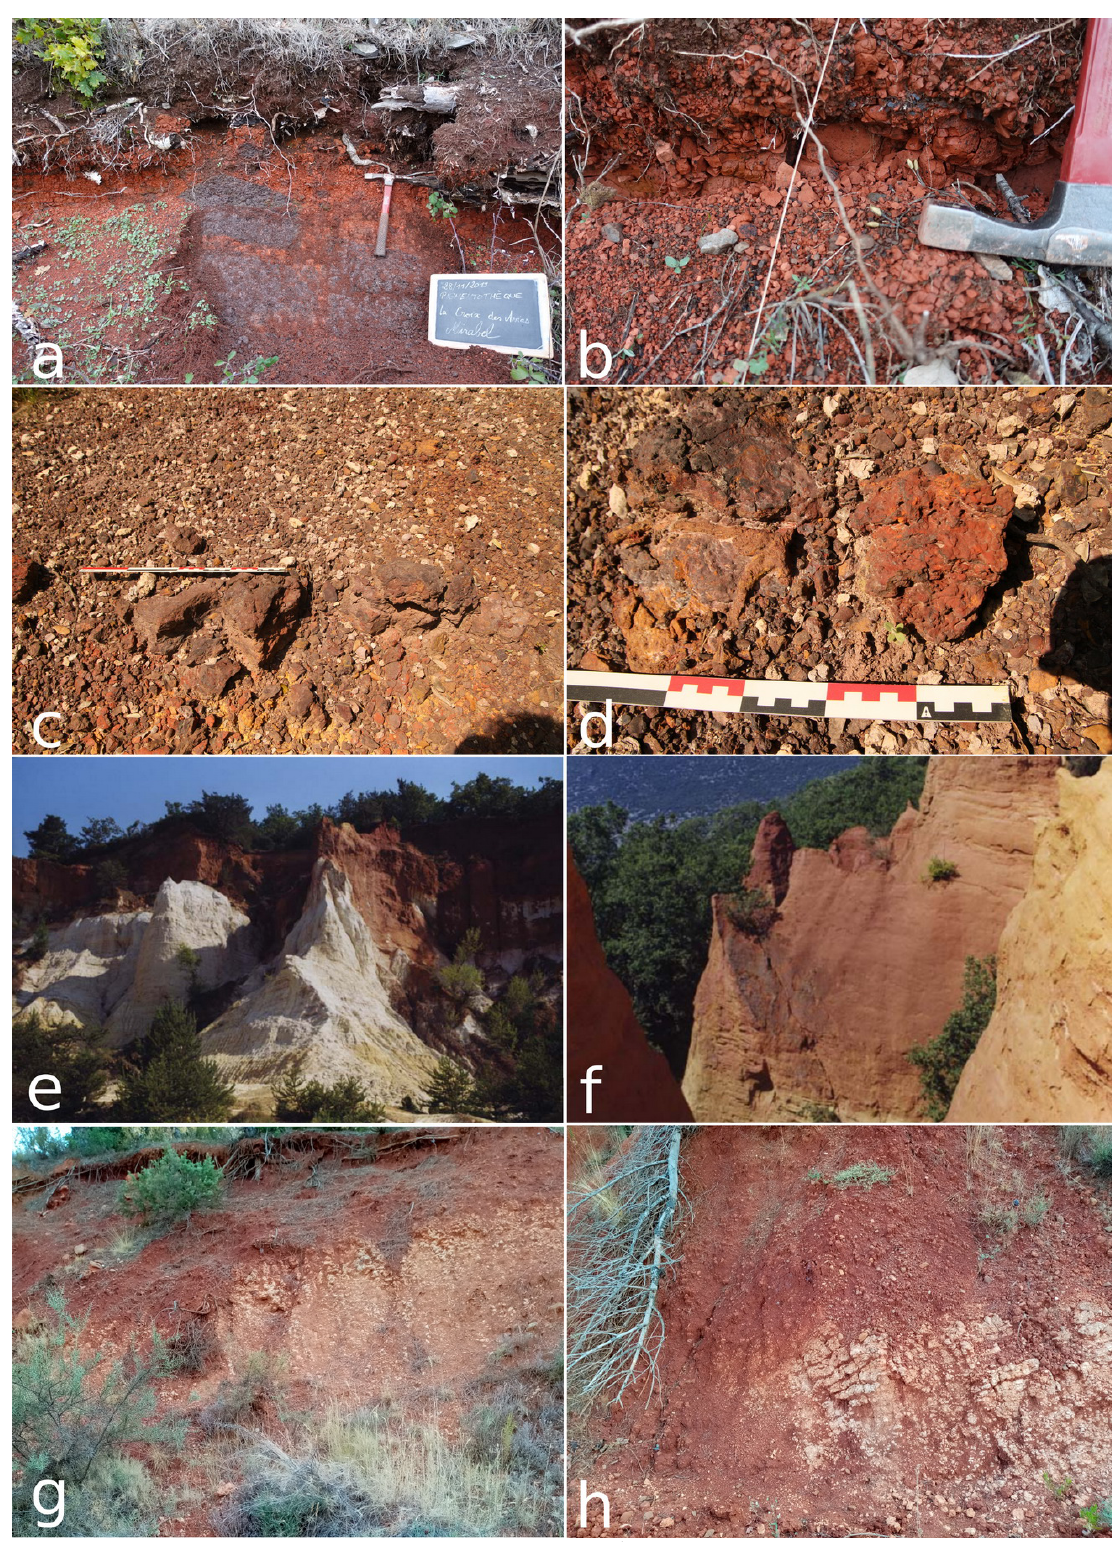
Figure 5. Iron oxide formation in weathering profiles: a-b) Palaeosol formed on basalt, Mirabel, Ardèche, France, c-d) Iron crust formed in a Middle Cenomanian sand containing kaolinite and ferruginous sandstone horizons, La Capelle-et-Masmolène, Gard, France, e-f) Ochre profile, weathered Albian-Cenomanian glauconitic sand, Roussillon, Vaucluse, France, e) top: ferricrust with underlying hematite-rich clayey sand; bottom: leached kaolinite-rich horizon, f) yellow goethite-rich and red hematite-rich horizons, g-h) Terra Rossa on Upper Gargasian-Clansayesian calcareous-marl, Maury, Pyrénées-orientales, France. Photos: H.